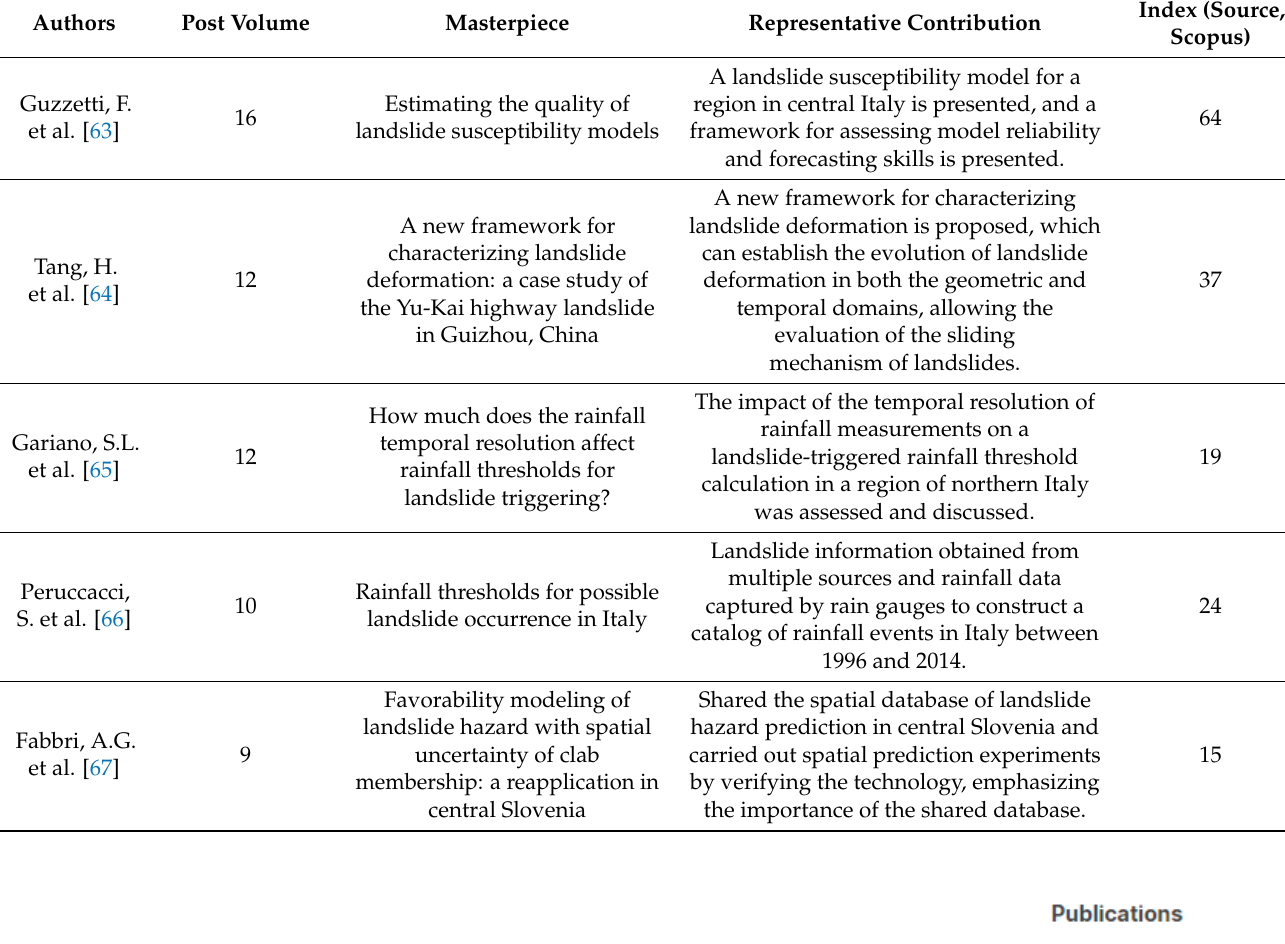
Table 2. Prolific author (top five).